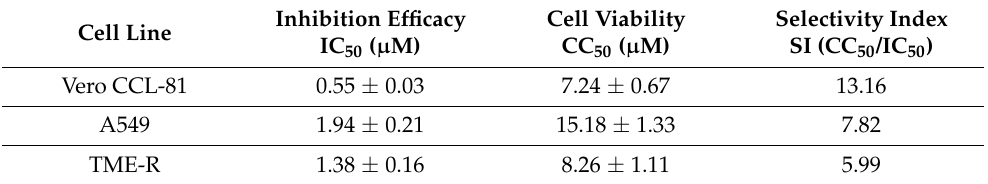
Table 1. Calculations of IC 50 , CC 50 and SI of ivermectin against USUV replication in vitro. Conven- tional parameters due to non-linear regression analysis performed by GraphPad Prism software 9 yielded inhibitory efficacy of ivermectin against USUV lineage Africa 3 (MOI of 0.1) and the corresponding cytotoxicity in Vero CCL-81, A549 and TME-R. Means ± SD of IC 50 and CC 50 val- ues in addition to elaborations of the SI as the quotient of CC 50 and IC 50 demonstrating the ratio between cytotoxicity and antiviral activity are depicted and referred to data from at least three independent